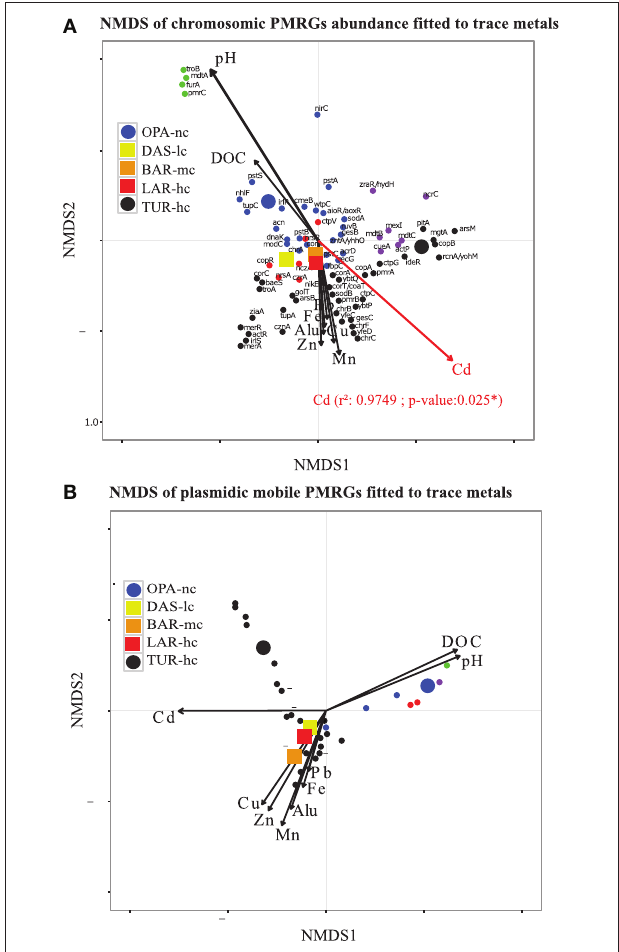
FIGURE 4 | Polymetallic resistance genes (PMRG) abundance correlation with trace metals. (A) For PMRG on chromosomes (72 genes), Cadmium (Cd) was significantly correlated with NMDS axes and it was the main explanatory factor of abundance variation of these genes between metacommunities. (B) NMDS axes based on relative abundance of PMRG located on plasmids (27 genes) do not significantly fit with any trace metal arrows. This NMDS analysis was performed with Bray–Curtis distance, three dimensions were a priori defined for distance rank ordination and stress value was below 0.05. NMDS loadings (NMDS1, NMDS2), and P -value of correlated trace metals are reported in Supplementary File S6 . Each small dot represented an individual PMRG, while each large point represents the lake communities’ samples using circles for OPA-nc in blue and the control TUR-hc in black, and the connected lakes were illustrated with squares, LAR-hc in red, BAR-mc in orange and DAS-lc in yellow. PMRG plot coordinates, clusters and dot labels are shown in Supplementary File S4 . Thresholds of 75% of identity, minimum alignment length of 50 base pairs and e -value of 10 − 12 parameters were strictly respected. PMRG were annotated by performing Blastn of ORFs against BacMet database using Diamond software.